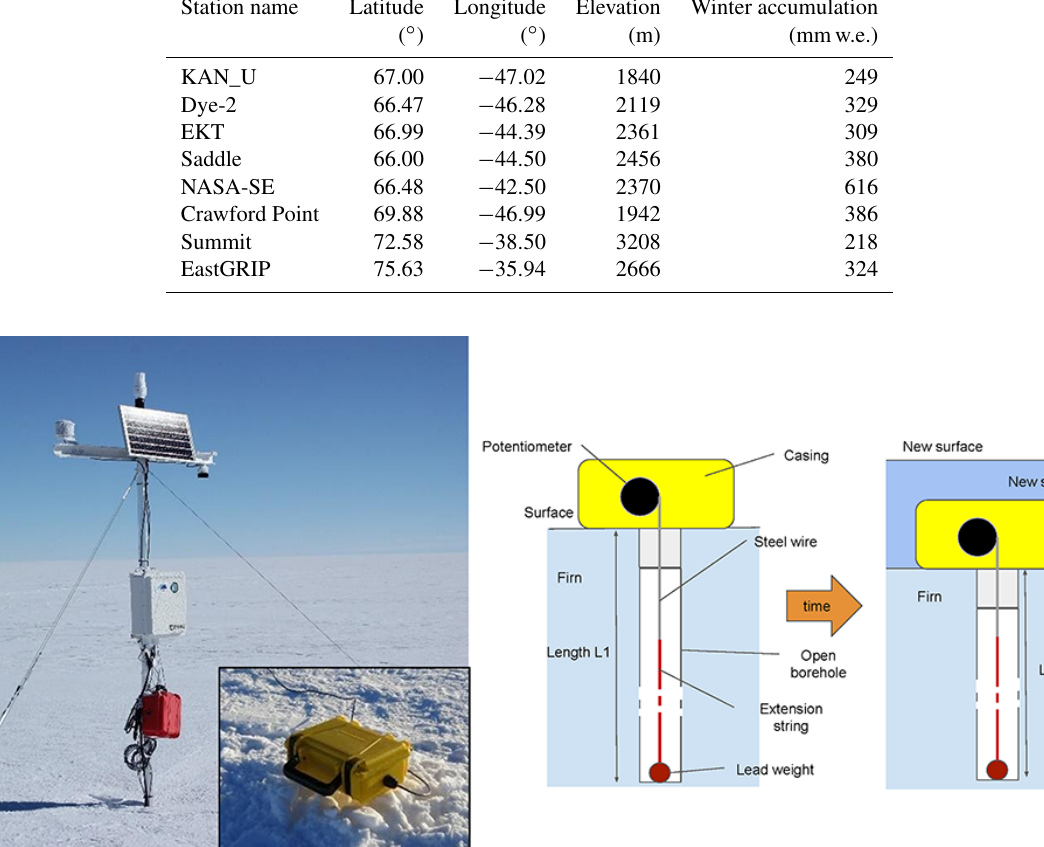
anchored using a 0.226 kg lead weight. Each potentiome- ter was independently calibrated before installation.